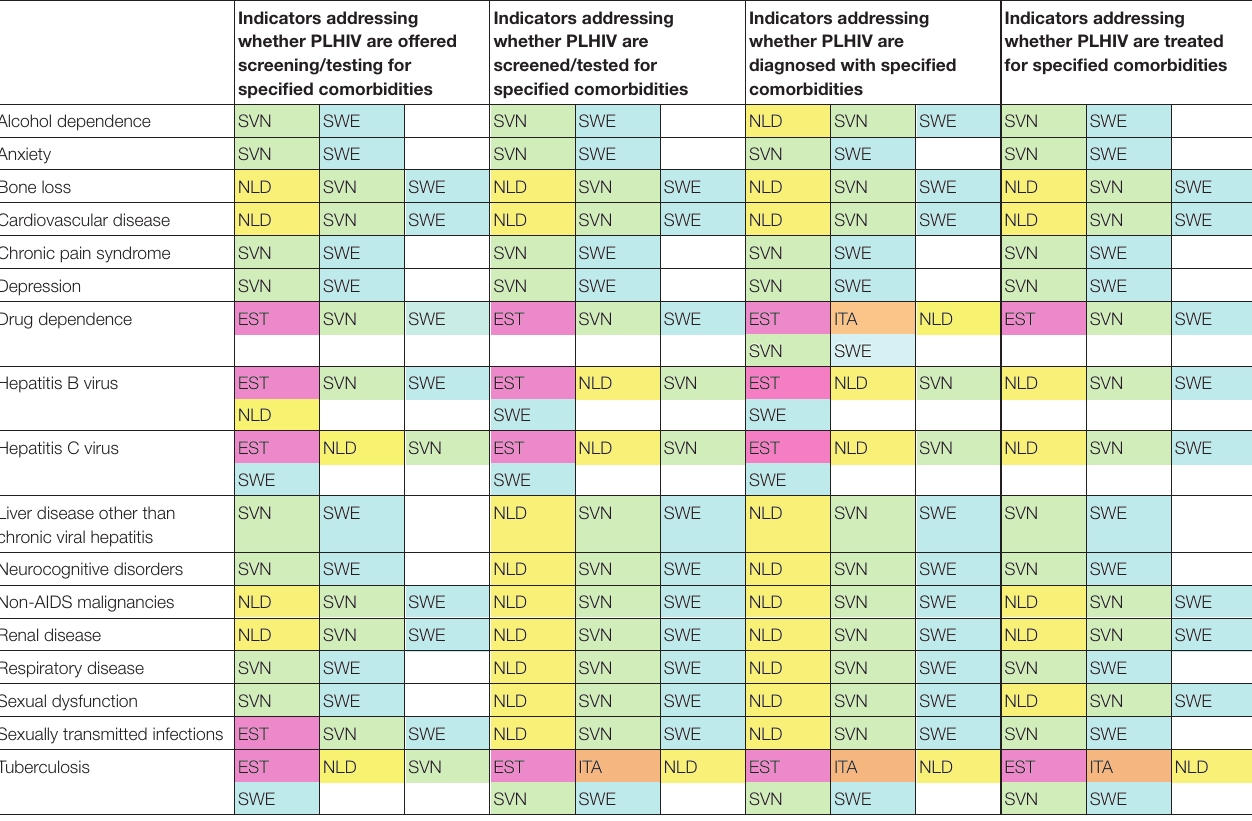
TABLE 2 | Reported ability of six* European countries to report on indicators for comorbidity screening/testing, diagnosis and treatment in PLHIV. Indicators addressing whether PLHIV are